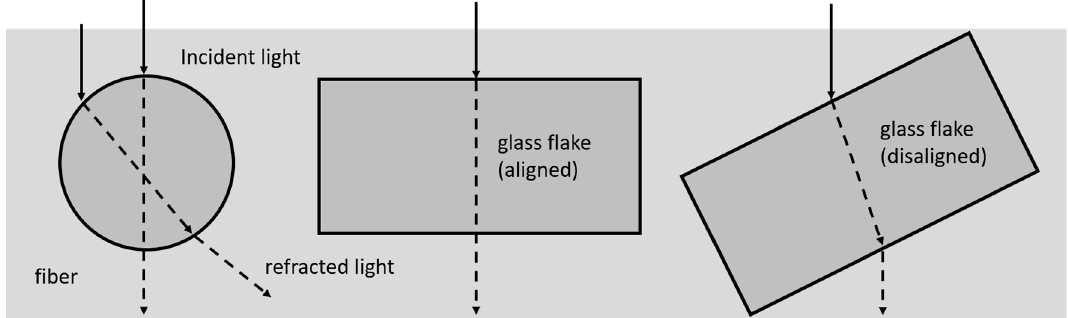
Figure 1. Schematics of the influence of glass fibers and glass flakes on transmitted light in a matrix with a mismatch of refractive indices.